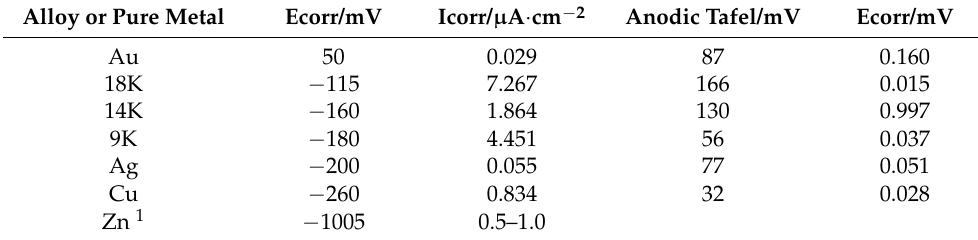
Table 4. Parameter for metals and gold alloys in 3.5% NaCl.